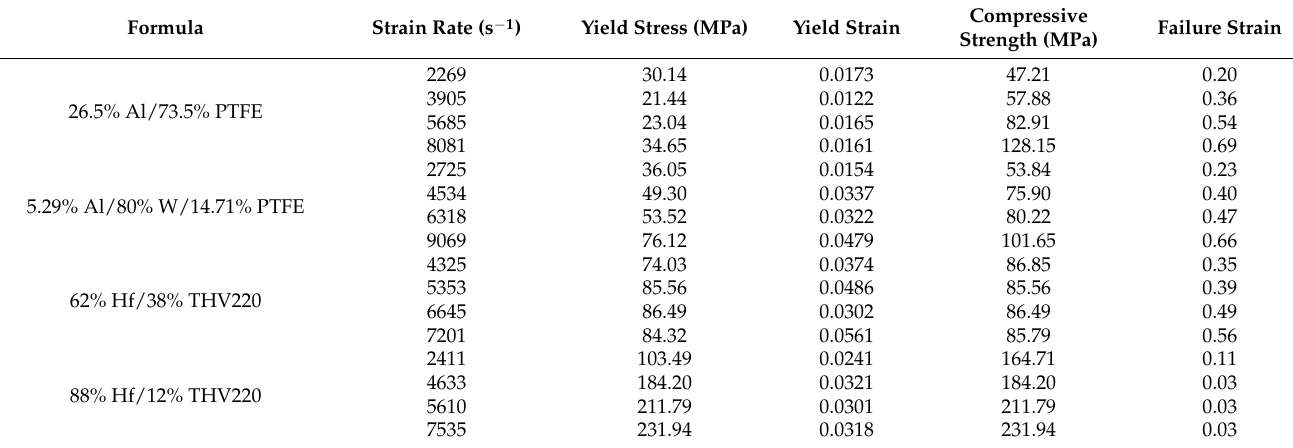
Table 3. Dynamic compressive performance of